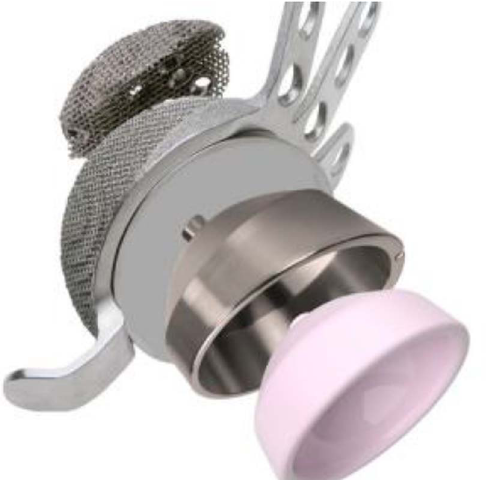
Figure 2. A fi gure showing the modularity of the cup and how to assemble the different components including the augment spacer and